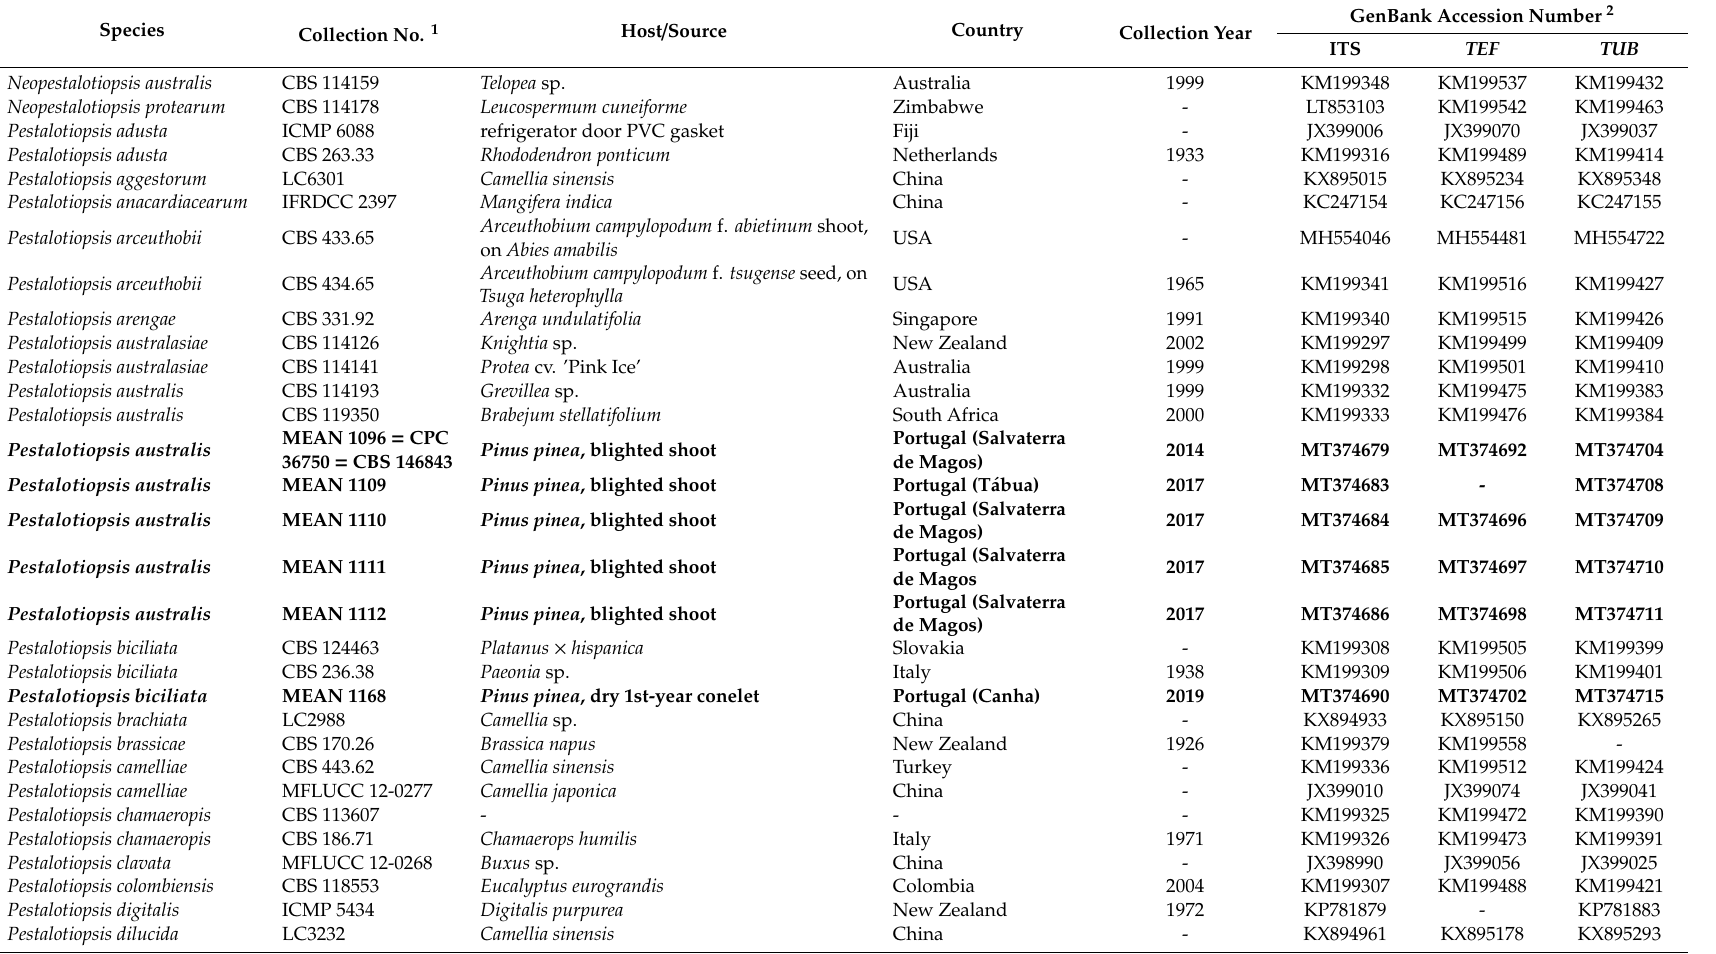
Table 1. Details of Pestalotiopsis isolates obtained in this study (bold) and of strains representing species of Pestalotiopsis and related genera retrieved from GenBank and used in phylogenetic